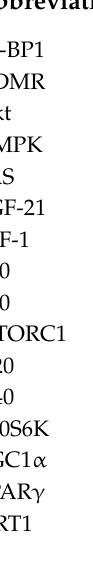
Figure S1: Fasting Insulin-like Growth Factor 1, Figure S2: Without boxes around Western blots, Table S1: Experimental Diet Composition, Table S2: Primer